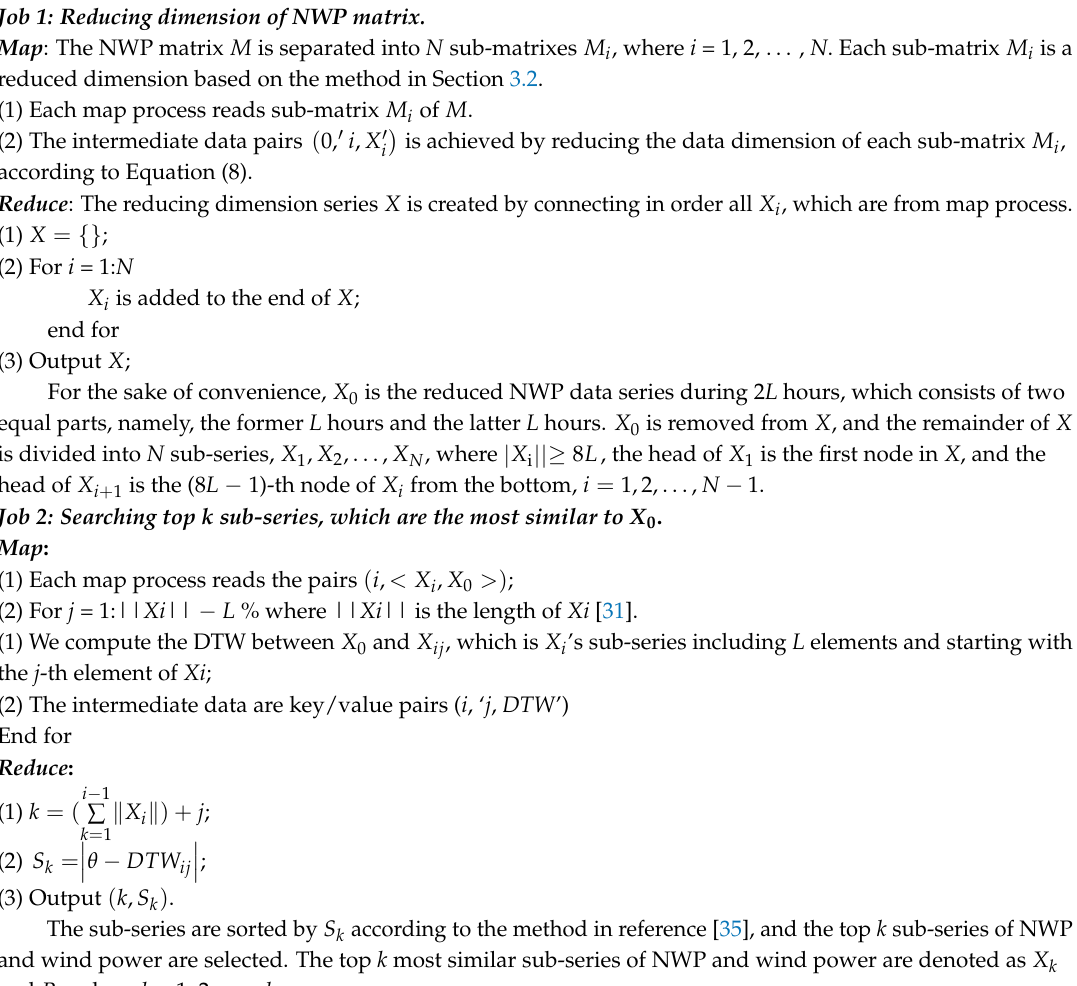
Algorithm 1. Parallel Ultra-short-term wind power prediction based on Map/reduce. Job 1: Reducing dimension of NWP